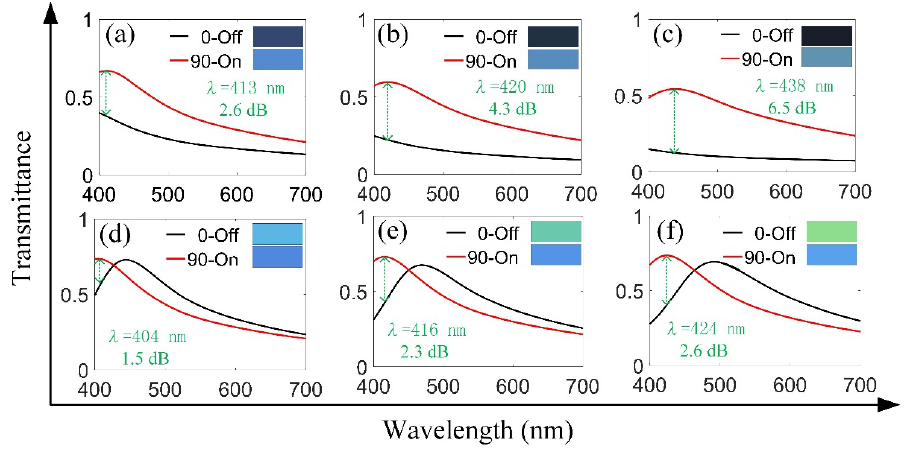
Figure 5. ( a – c ) Transmittances of different number of Ni metal strips; ( d – f ) Transmittances of different number of Si strips. Appl. Sci. 2020 , 10 , x FOR PEER REVIEW